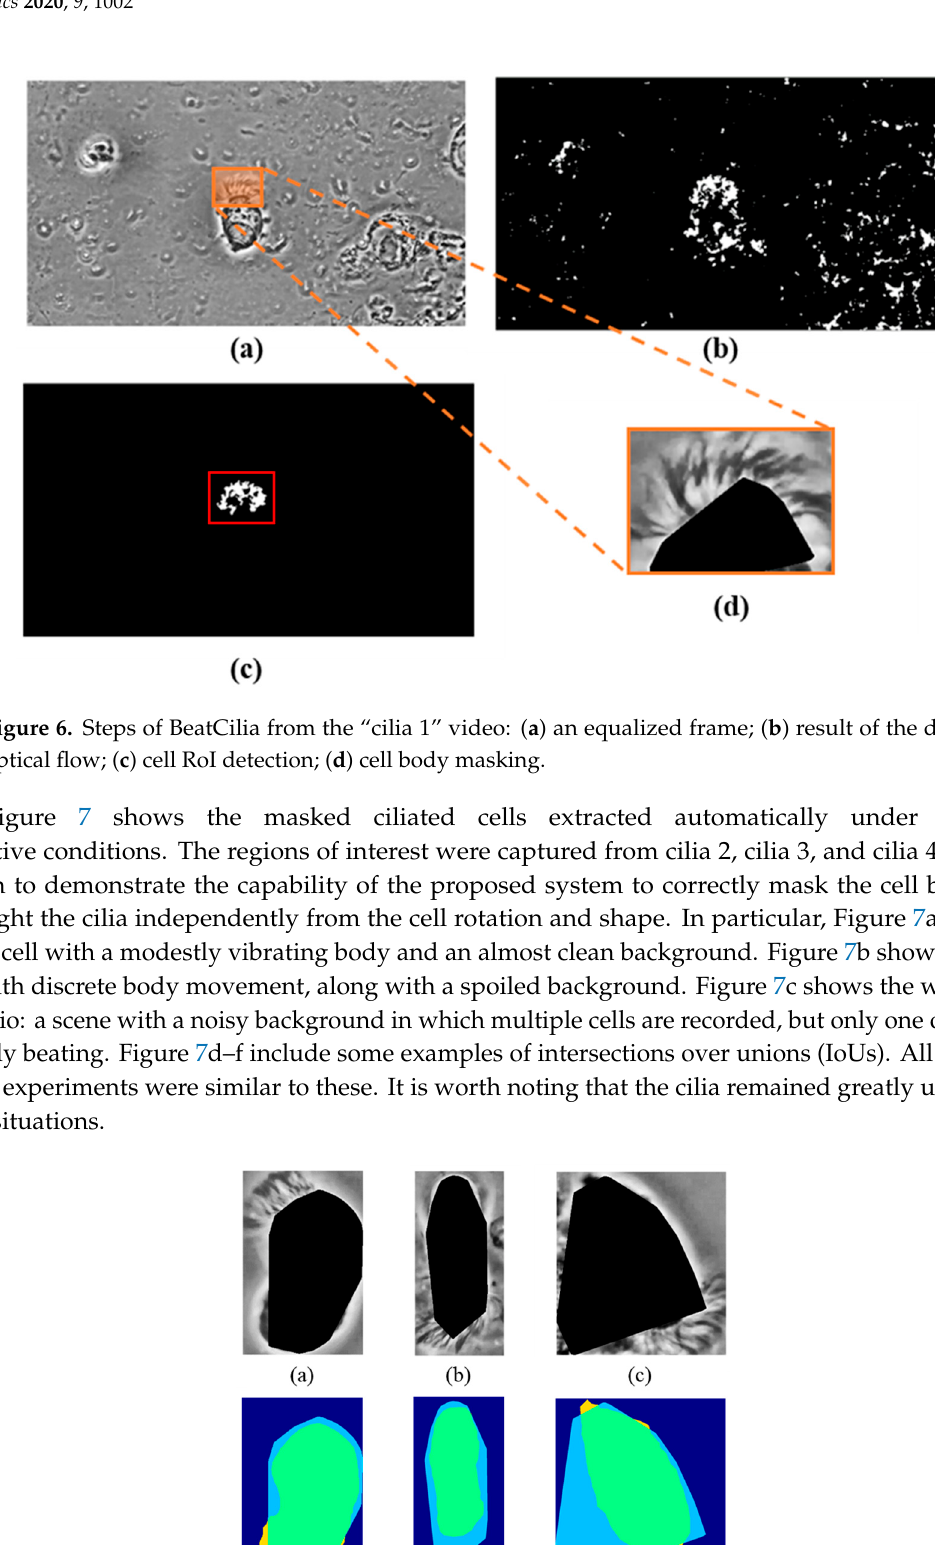
7 of 15 Figure 5. Example of the Fourier transform from simulation S3, with evidence (orange) of the frequency peak (14 Hz) and the fundamental frequency (0 Hz). In order to validate the proposed approach, a second experiment was conducted on real ciliated cell videos taken from the dataset described in Section 2.1. The resulting estimated CBFs were compared with a ground truth value that has been manually determined by an expert. This experiment has three different goals: 1. Testing the effectiveness of the cell RoI detection; 2.